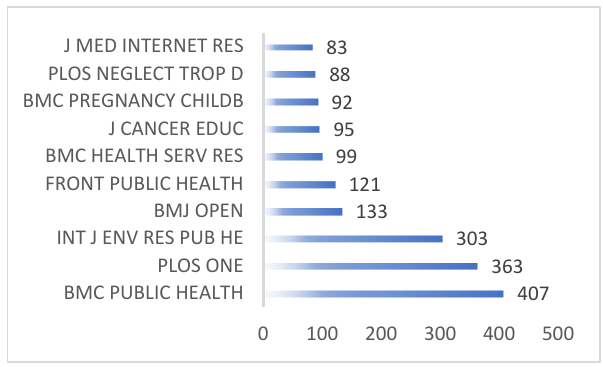
Figure 2. The top ten most fruitful journals.